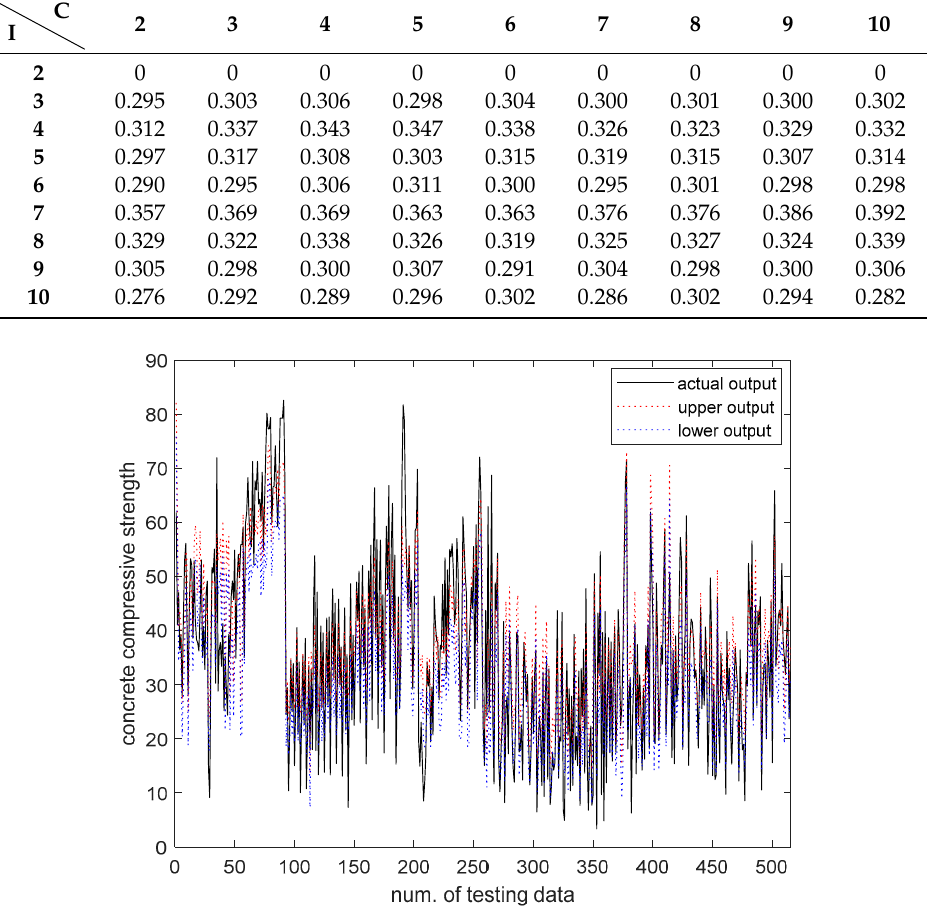
Table 2. CCS prediction results for interval-based IGM (Case 1) using testing data.